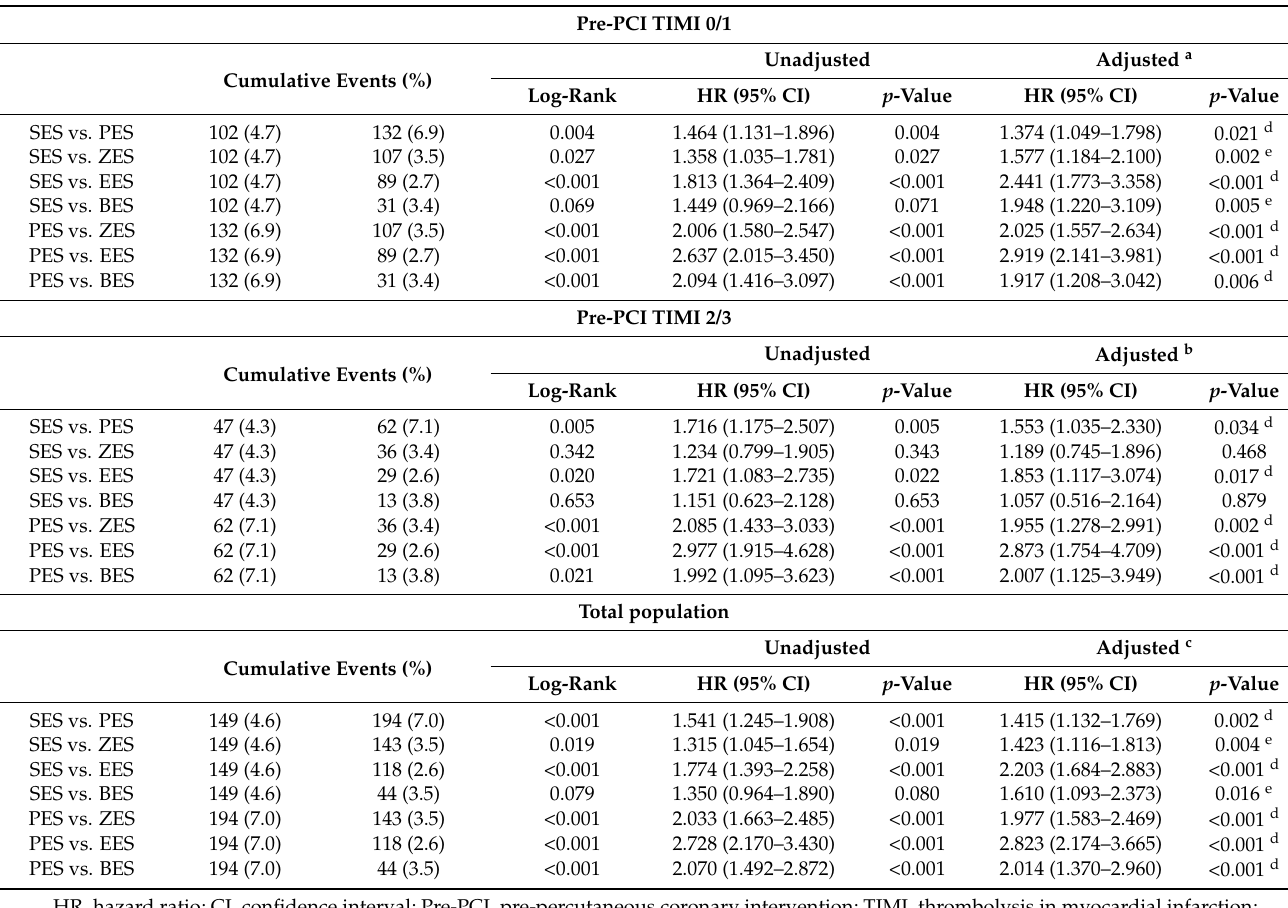
IRA, infarct-related artery; LAD, left anterior descending coronary artery; RCA, right coronary artery; LM, left main coronary artery; ACC/AHA, American College of Cardiology/American Heart Association; GP, glycoprotein; IVUS, intravascular ultrasound; OCT, optical coherence tomography; FFR, fractional flow reserve; PCI, percutaneous coronary intervention. a Adjusted by male, age, LVEF, BMI, Killip class I/II/III, SBP, CPR on admission, dyslipidemia, previous MI, previous PCI, peak CK-MB, troponin-I, NT-ProBNP, high-sensitivity CRP, serum creatinine, total cholesterol, triglyceride, HDL-cholesterol, aspirin, clopidogrel, ticagrelor, prasugrel, cilostazole, beta-blocker, CCB, LAD, and RCA (IRA and treated vessel), LM (treated vessel), single-vessel disease, two-vessel disease, ≥ three-vessel disease, ACC/AHA type B2/C lesions, in-hospital GP IIb/IIIa, IVUS, OCT, FFR, culprit-only PCI, stent diameter, stent length, and number of